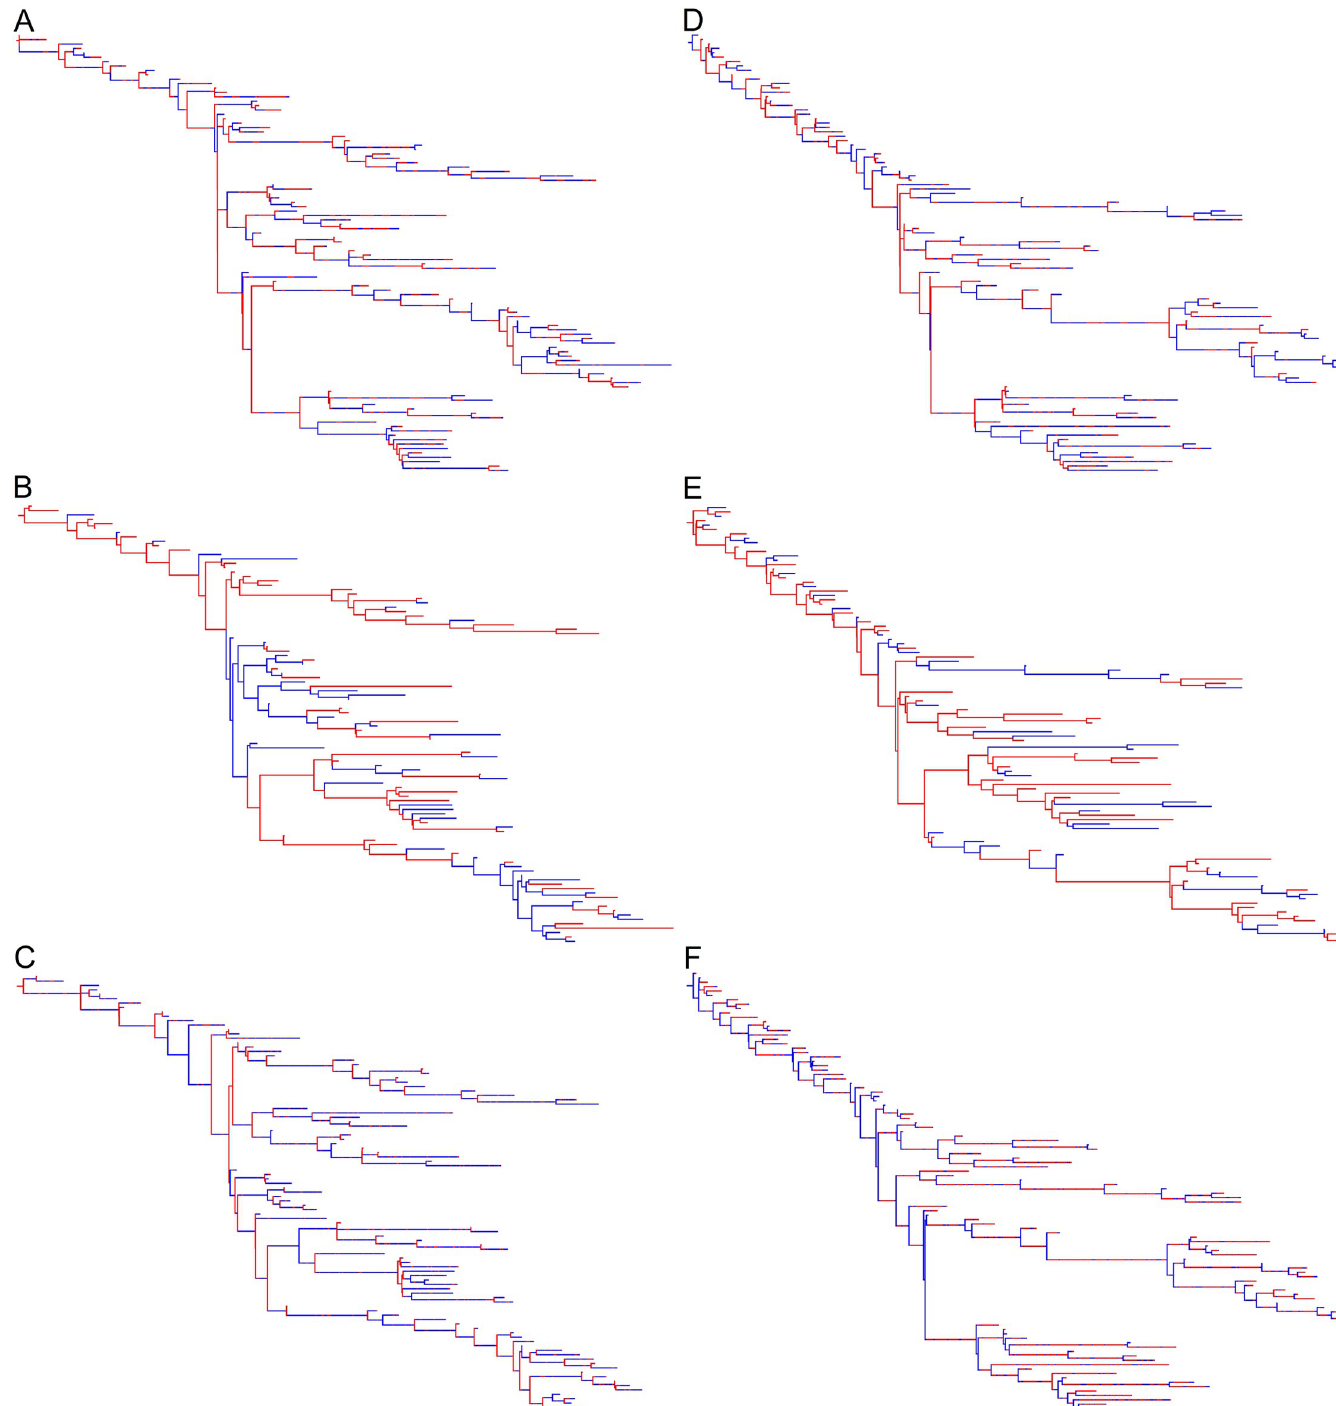
Fig 11. Sampled transmission tree (A and D), maximum clade credibility tree produced by the DTA model (B and E) and maximum a posteriori tree produced by the SC model (C and F), for a representative of the 23 simulated outbreaks that 100 isolates were sampled randomly (A-C) and equally over time (D-F). The blue areas represent time spent in the human population and the red areas represent time spent in the animal